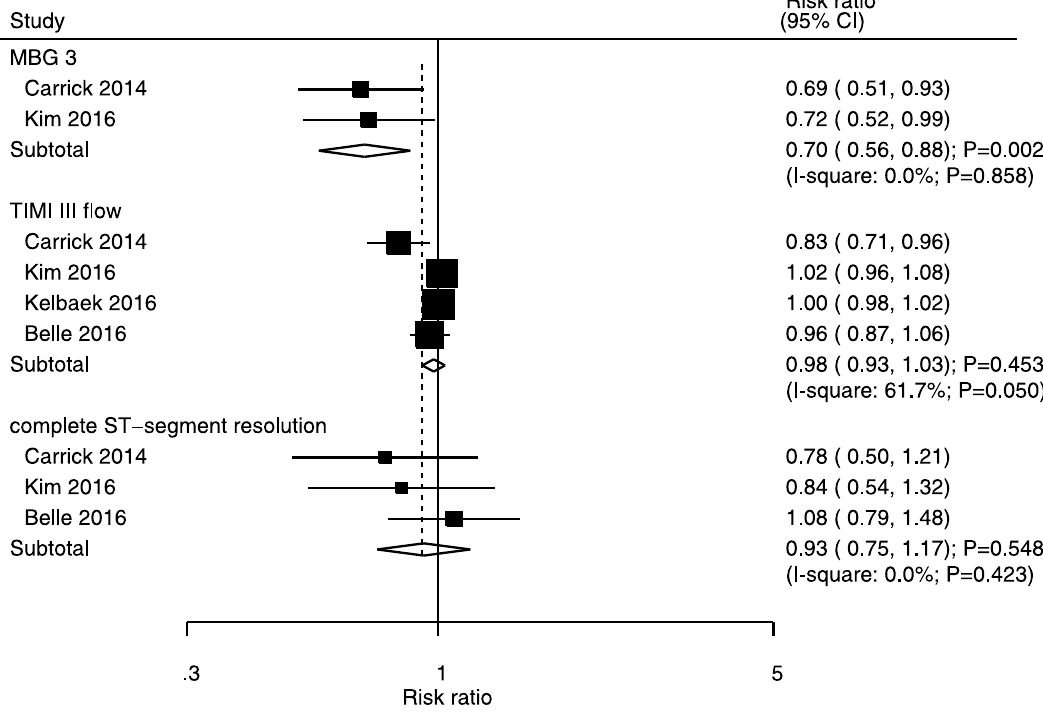
Fig 8. Immediate versus deferred PCI for MBG 3, TIMI III flow and complete ST-segment resolution.